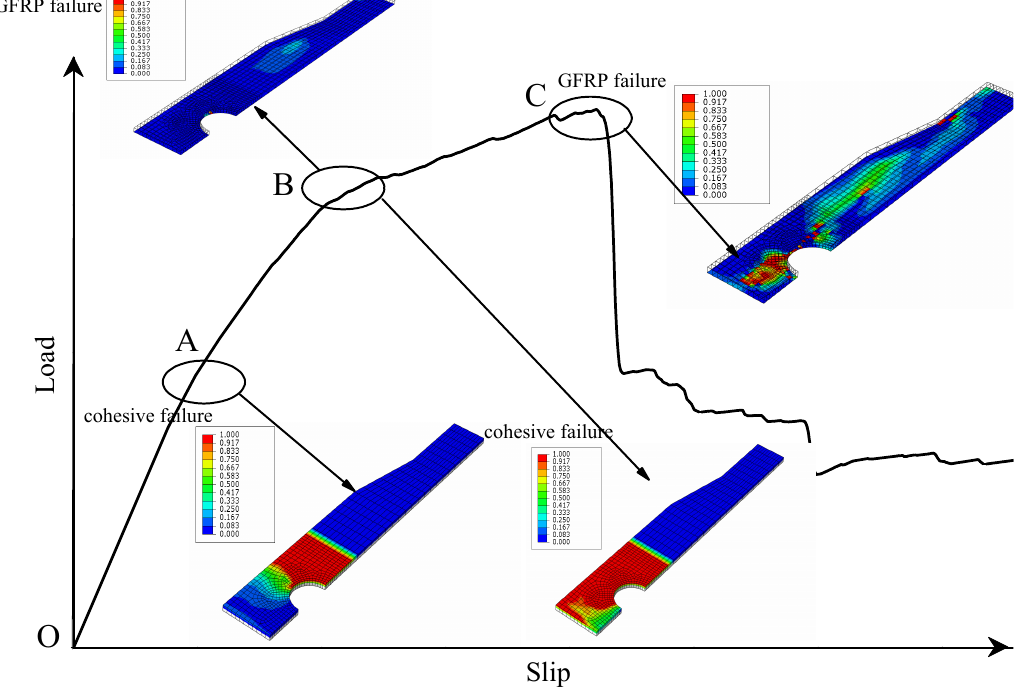
Figure 14. Generalization of SCGPC failure process.